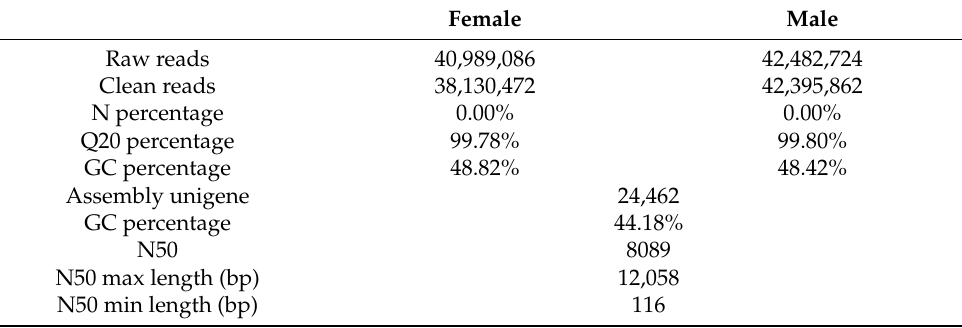
Table 1. Statistics of the antennal transcriptome of Glenea cantor